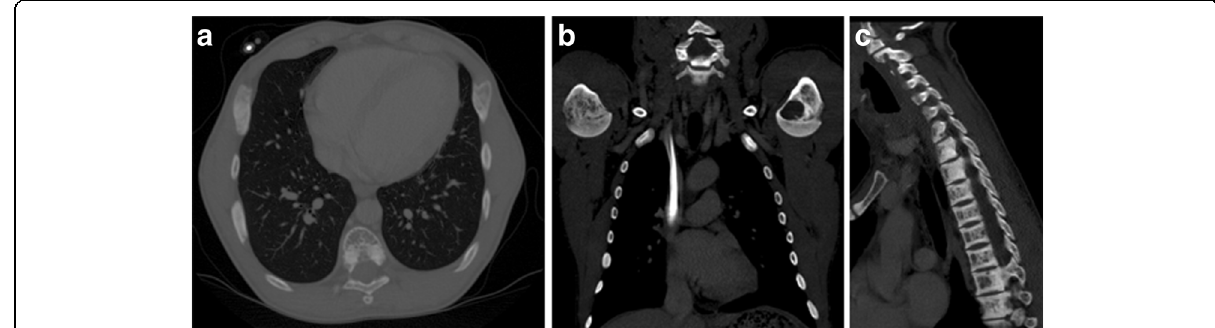
Fig. 18 a – c Patients with secondary hyperparathyroidism due to chronic renal failure. CT demonstrated asymptomatic bilateral mixed lytic/sclerotic expansile rib lesions, lytic lesion in the left humeral head and the rugger-jersey